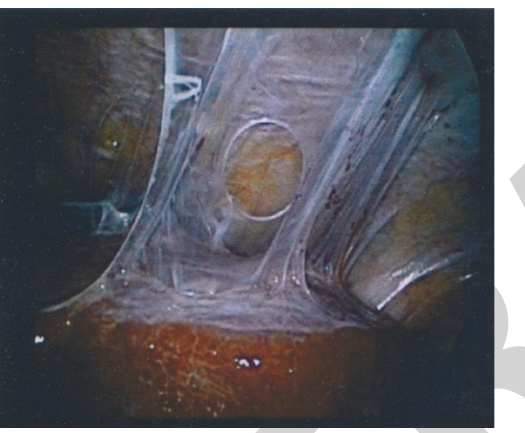
Figure 2: Demonstrates extensive adhesions between liver and anterior abdominal wall (violin-string